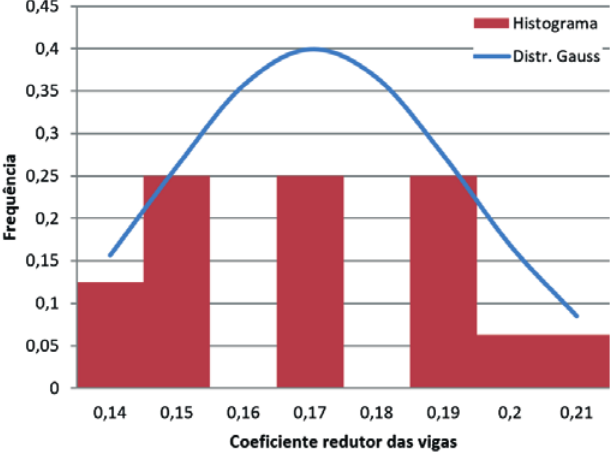
Figura 8 Distribuição de Gauss x Histrograma para a rigidez das vigas nos exemplos com 1 pavimento